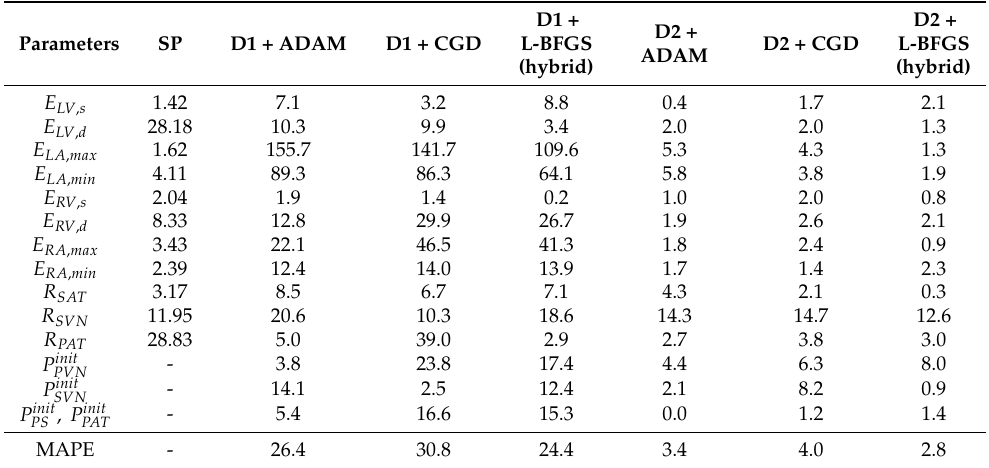
Table 4. Absolute percentage errors (APEs—Equation (30)) per parameter for datasets generated using nominal model